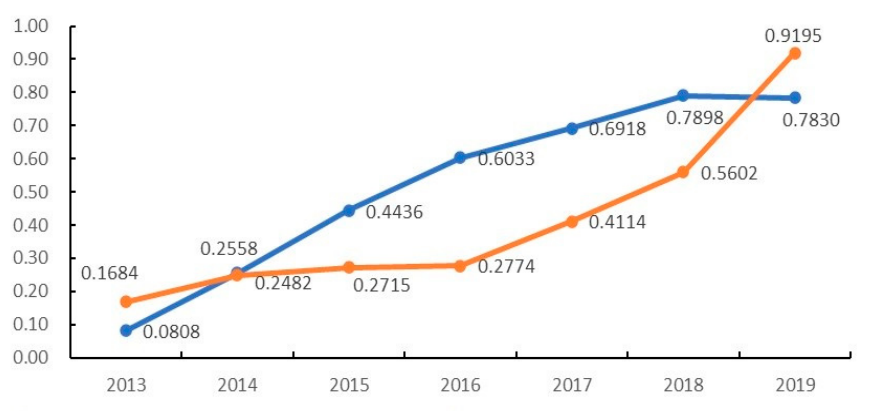
Figure 9. Comprehensive development evaluation value of relevant indicators of “coal phase-out” in China and